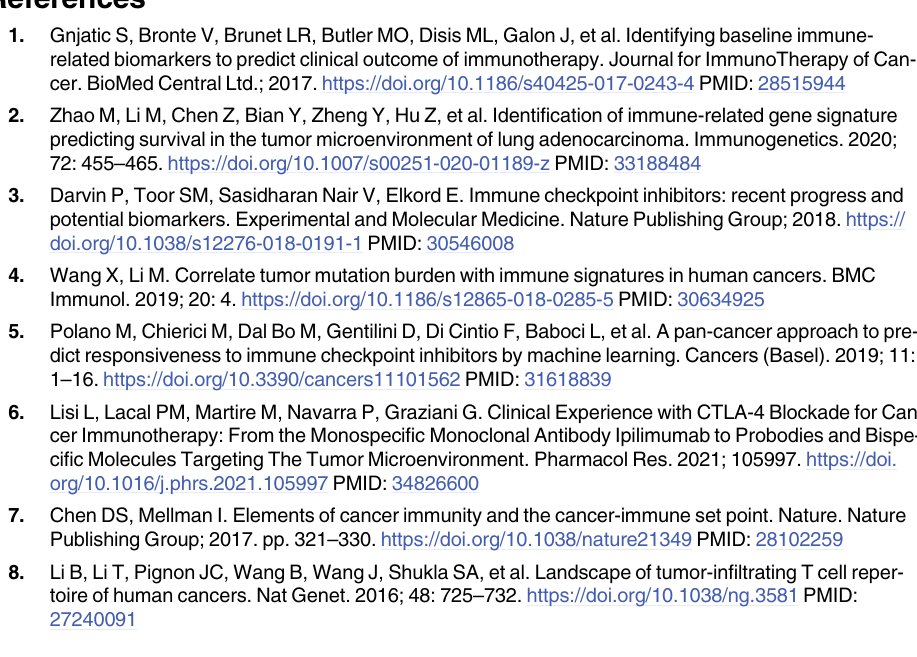
S7 Table. CIBERSORT table reporting values of 22 types of immune cell proportions according to cancer